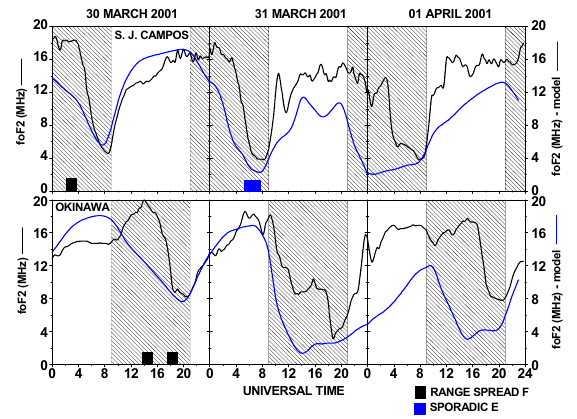
Figure 2a Figure 2b Fig. 2b. F-region minimum virtual height ( h 0 F – red) and hp F2 Fig. 2a. F-region critical frequency ( fo F2) variations (black) ob- (black) variations observed at low-latitude stations S˜ao Jos´e dos served at low-latitude stations S˜ao Jos´e dos Campos and Okinawa Campos and Okinawa during the period 30 March–1 April 2001. during the period 30 March–1 April 2001. The hatched portions in- The hatched portions indicate the local nighttime (18:00–06:00 LT) dicate the local nighttime (18:00–06:00 LT) periods. The black and periods. The black and blue horizontal bars indicate the presence of blue horizontal bars indicate the presence of range spread-F and range spread-F and sporadic E, respectively. Peak F-region height sporadic E, respectively. Peak F-region critical frequency ( fo F2) ( hm F2) variations obtained from the ASPEN-TIMEGCM model variations obtained from the ASPEN-TIMEGCM model runs are runs are also shown also shown (blue).